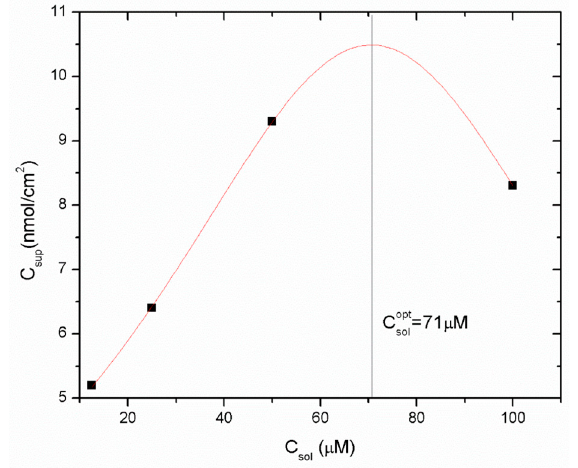
Figure 5 . Immobilization yield expressed as nmol of bound 1018K6 per cm 2 of PET surface as function of peptide concentration. The dose-response curve has been built by using the Holliday model. Data are expressed as means ± standard deviations. Standard deviation values lower than 5% are not shown.